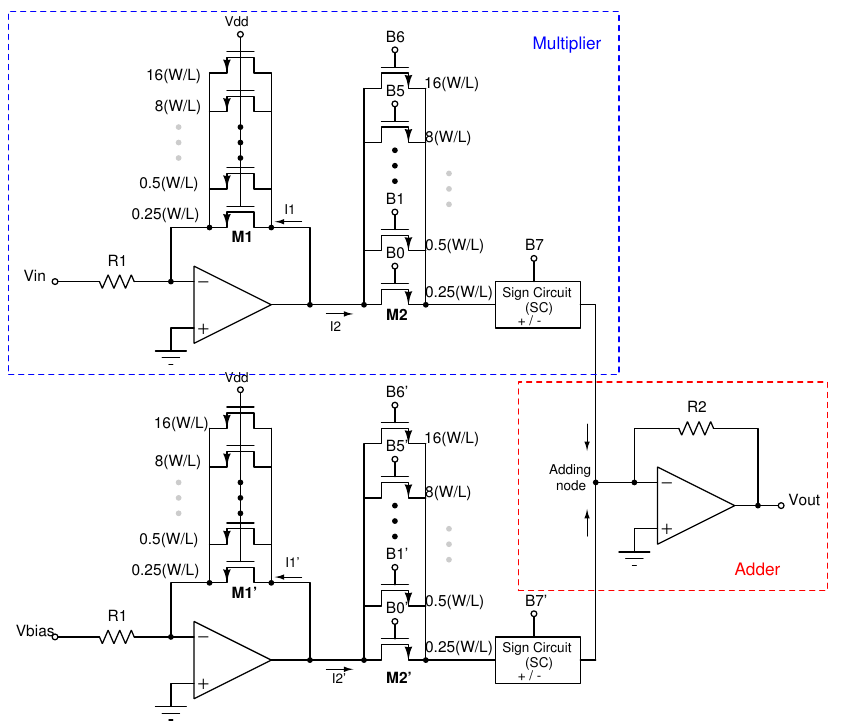
Figure 2. Eight-bit mixed-mode programmable multiplier and